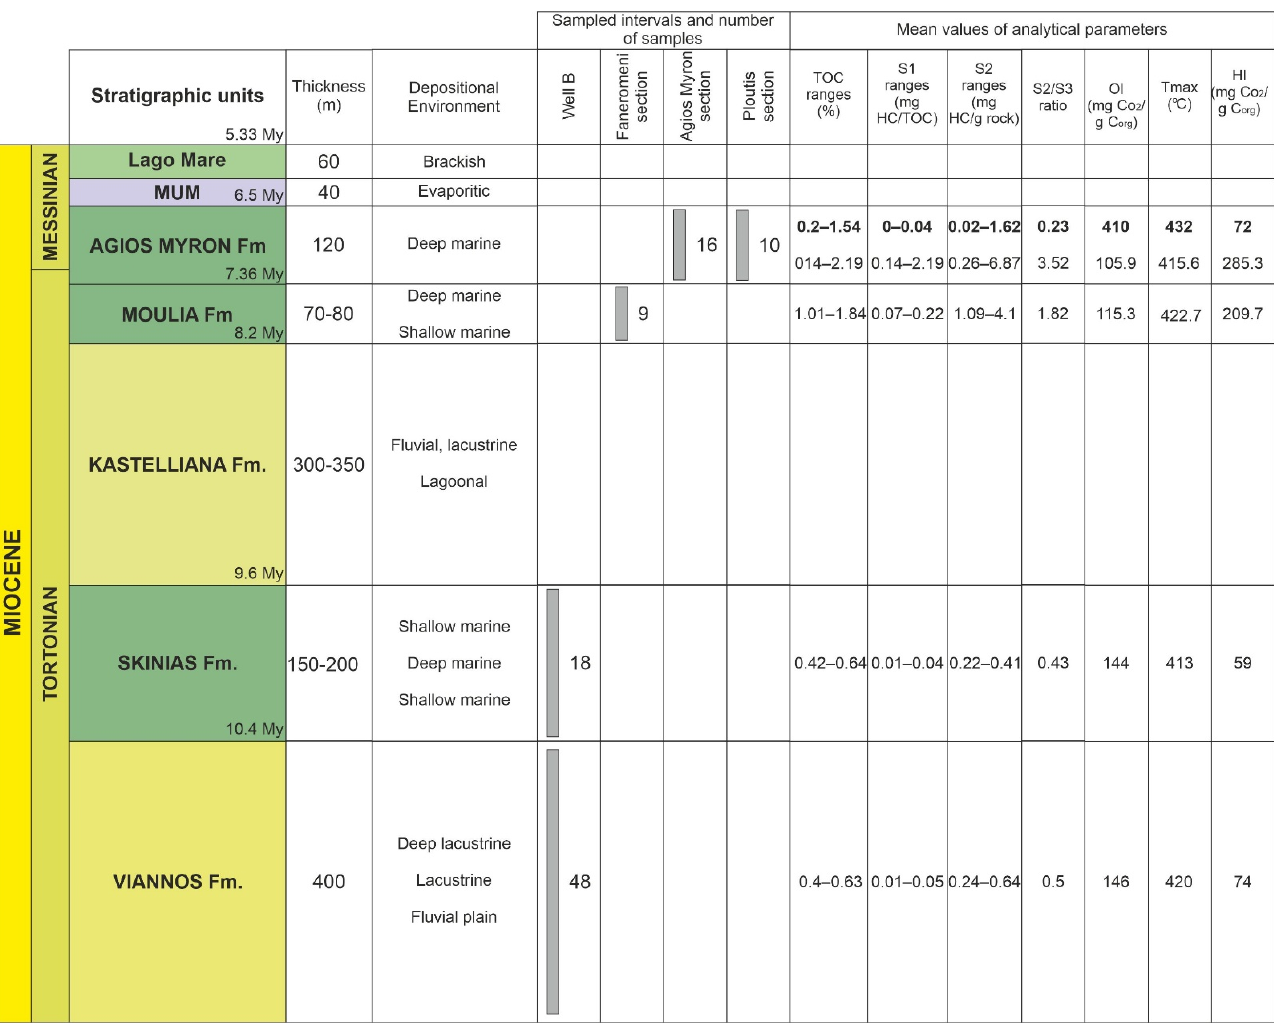
Figure 3. Stratigraphic column of the study region that illustrates the evolution of the Upper Miocene (Tortonian—Messinian) depositional environments. The age constraints of the study formations come from Zachariasse et al. [48]. To the left upper corner, the stratigraphic interval that the study sections and formations cover is displayed. Abbreviation, MUM: Marine Upper Messinian.